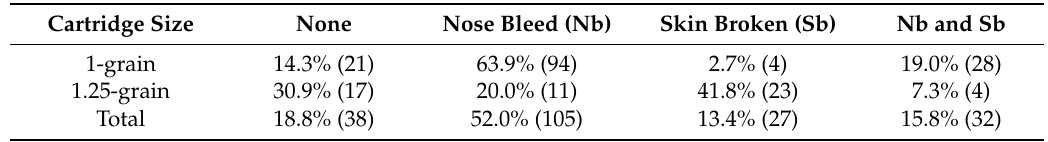
Table 6. The percentage of piglets with nose bleed and broken skin by cartridge size. Actual numbers are in brackets. There was a highly significant association between grain size and condition (chi-square = 70.03, df = 3, exact p < 0.001). Analysis of the effect of haemorrhages from the nasal passages and skin lacerations is given in Tables 4 and